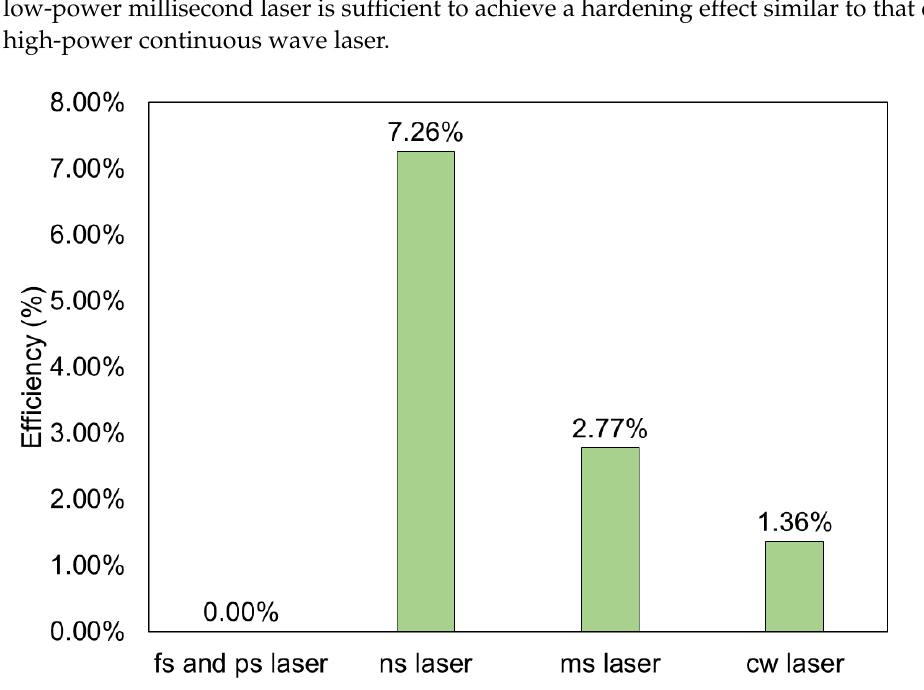
Figure 5. Hardening efficiency comparison for different pulsed lasers used in our previous study [5].